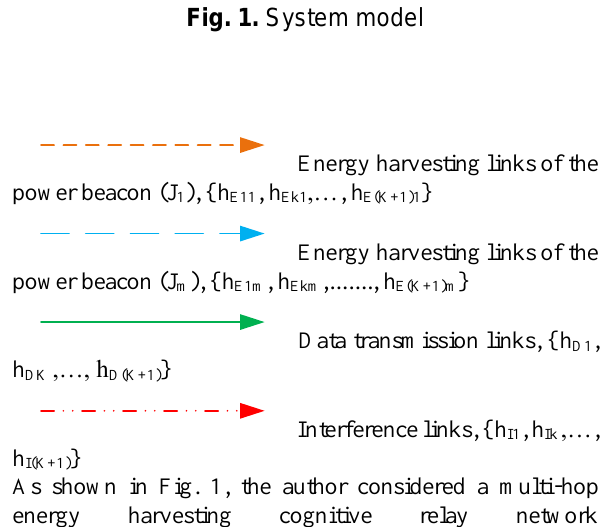
Fig. 1. System model